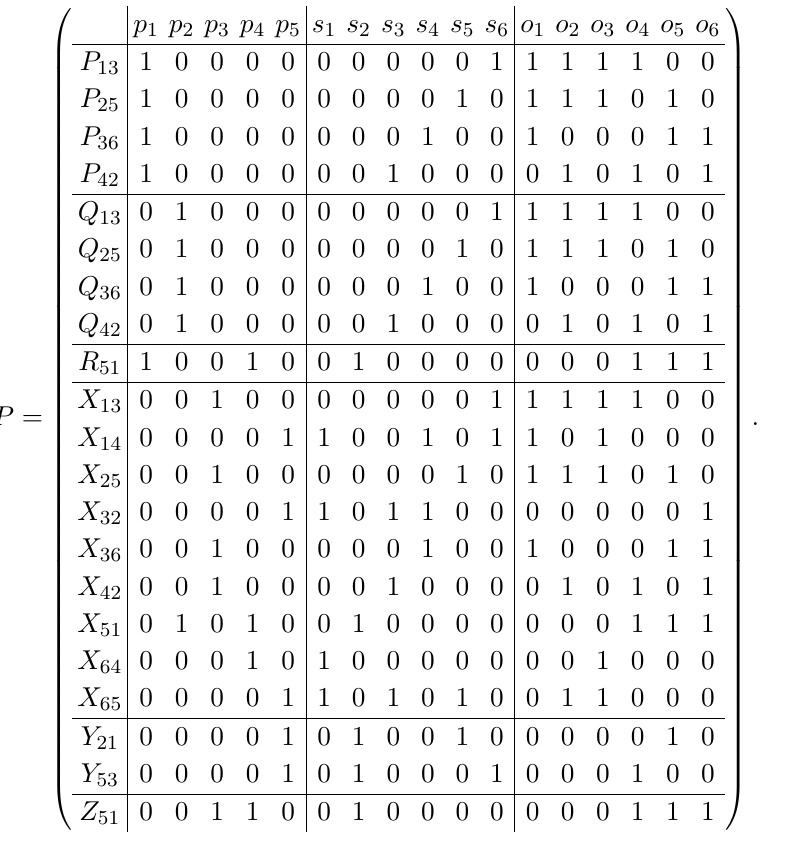
Using the forward algorithm, we are able to obtain the brick matchings for Model